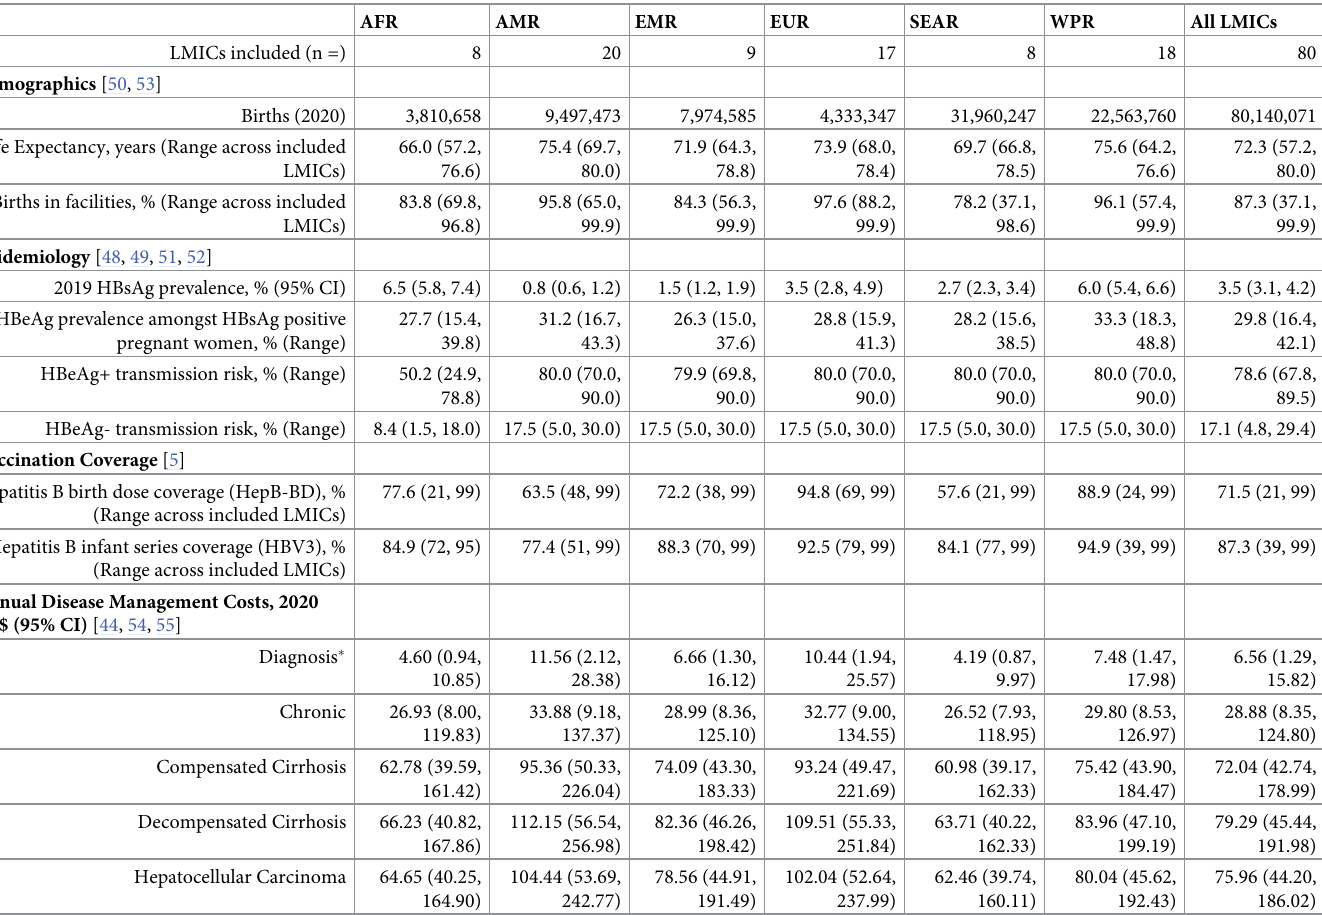
Table 2. Regional level model inputs.